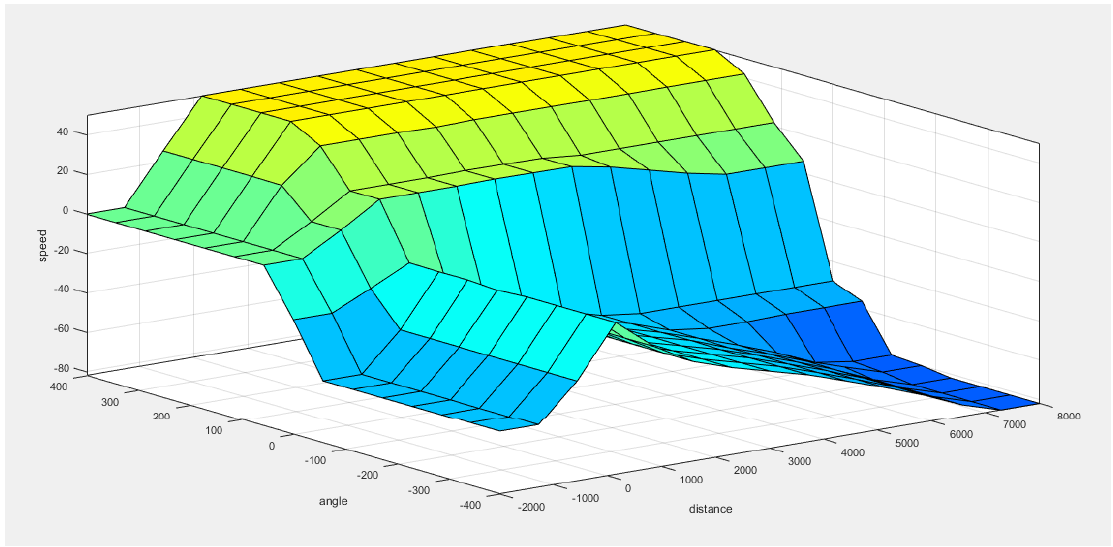
Figure 7. Graphical representation of the fuzzy control system.